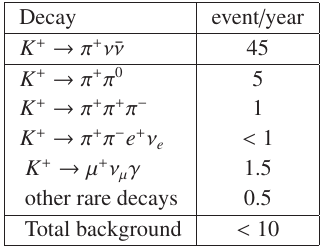
Table 1. Expected signal and background from K + decays estimated from NA62 sensitivity